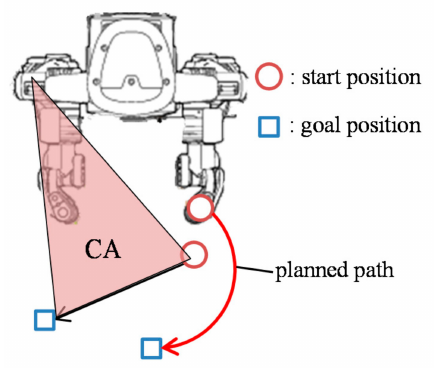
Figure 3. Definition of the CA (Collision